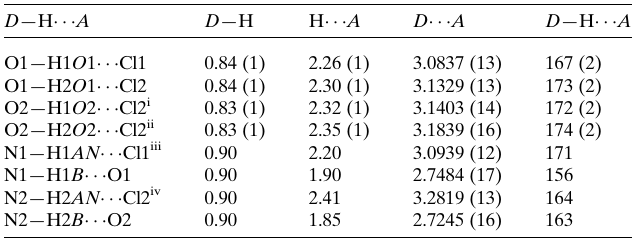
Table 1 Hydrogen-bond geometry (A˚ , (cid:4) ).